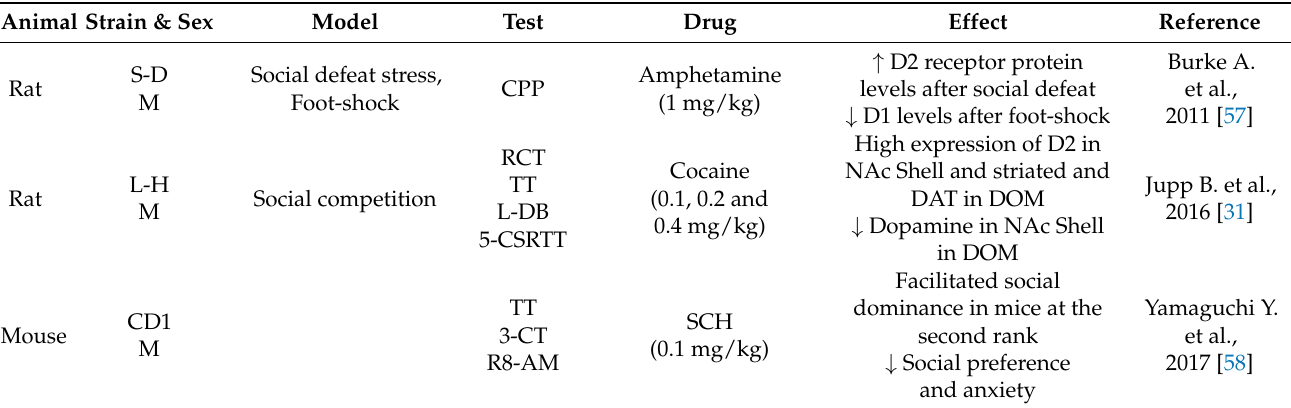
Table 4. Social stress and dopaminergic